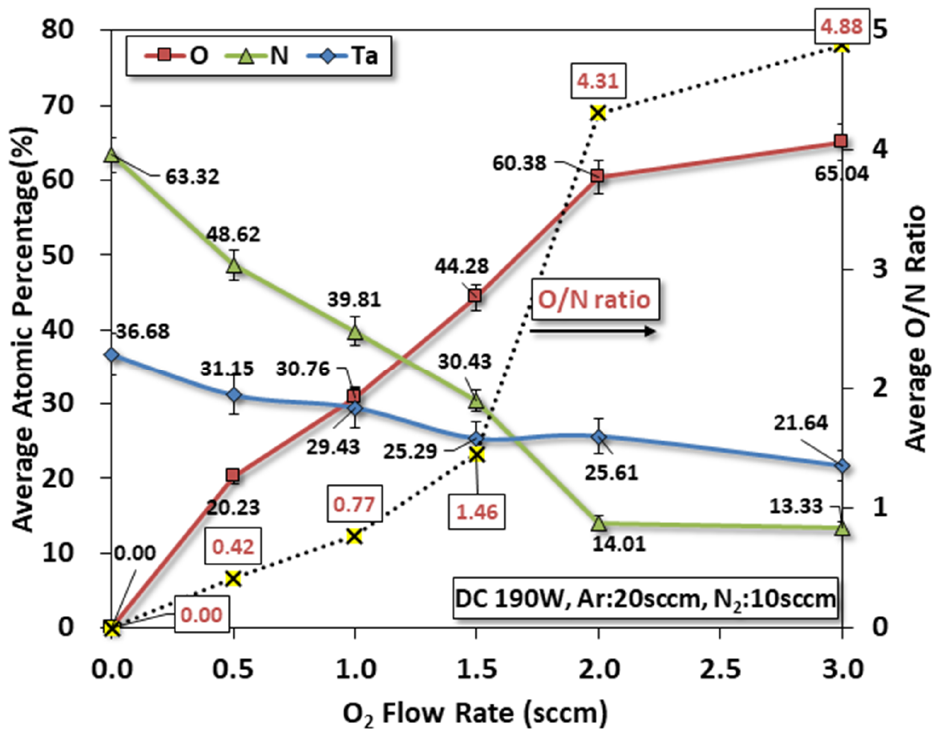
Figure 4. Estimated elemental compositions from EDS of annealed films under different oxygen flow rates.